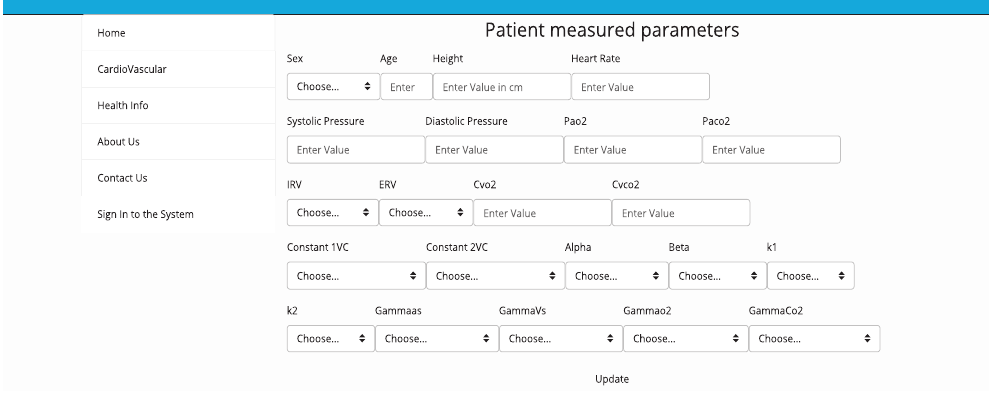
Figure 8: Nurse page.